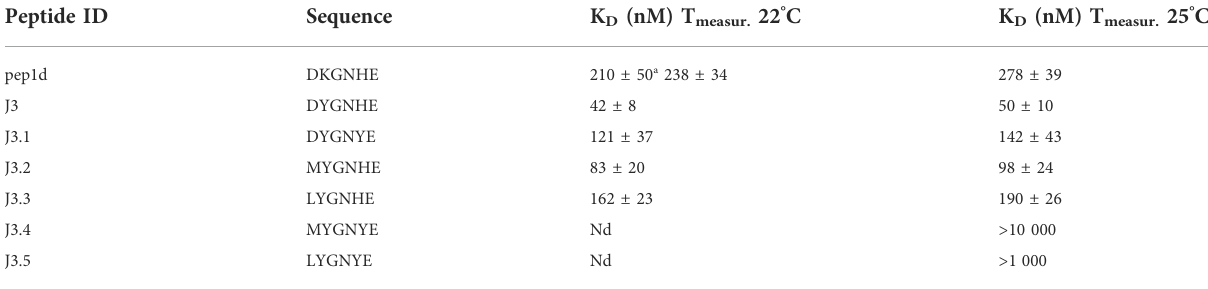
TABLE 2 Binding af fi nity of the tested peptides (and the reference initial peptide pep1d: DKGNHE) to RBD domain of the SARS-CoV-2 S protein determined with the aid of MST. The two different temperatures were applied to be able to compare results with the previously reported values (Odolczyk et al.,